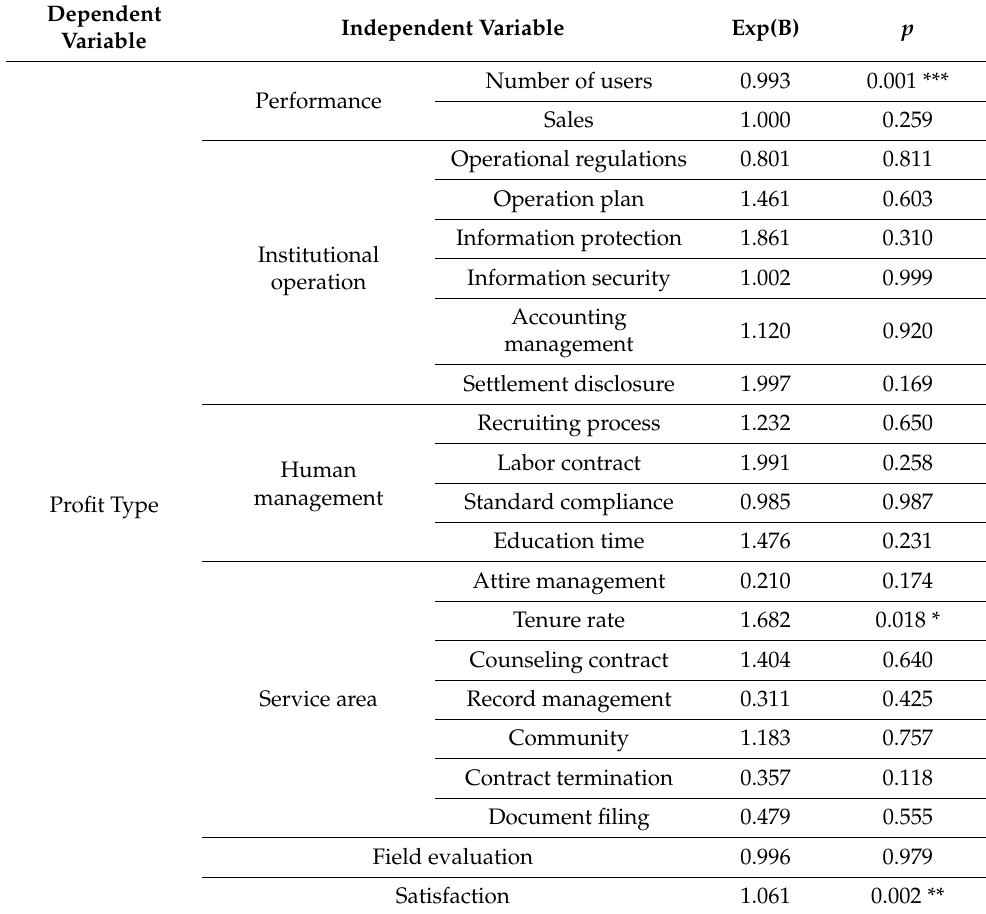
Table 3. Common indexes for QE (Quality Evaluation) of social services in 2016 (for-profit). ( n =